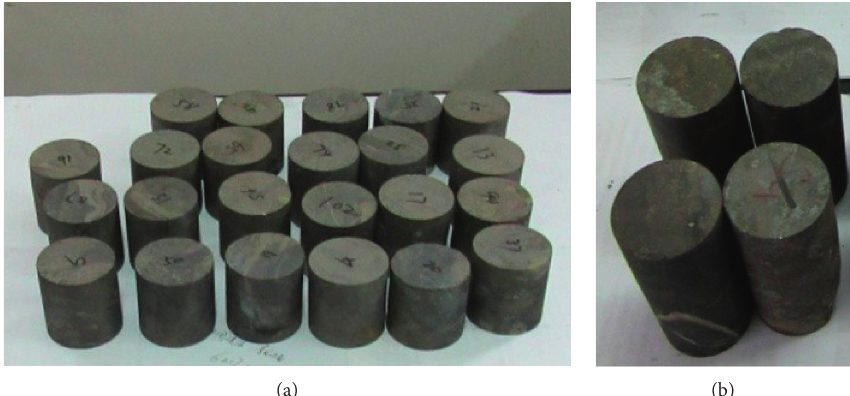
Figure 1: The physical picture of the processed rock sample (part of the samples): (a) Height-diameter ratio is 1:1; (b) height-diameter ratio is 2:1.